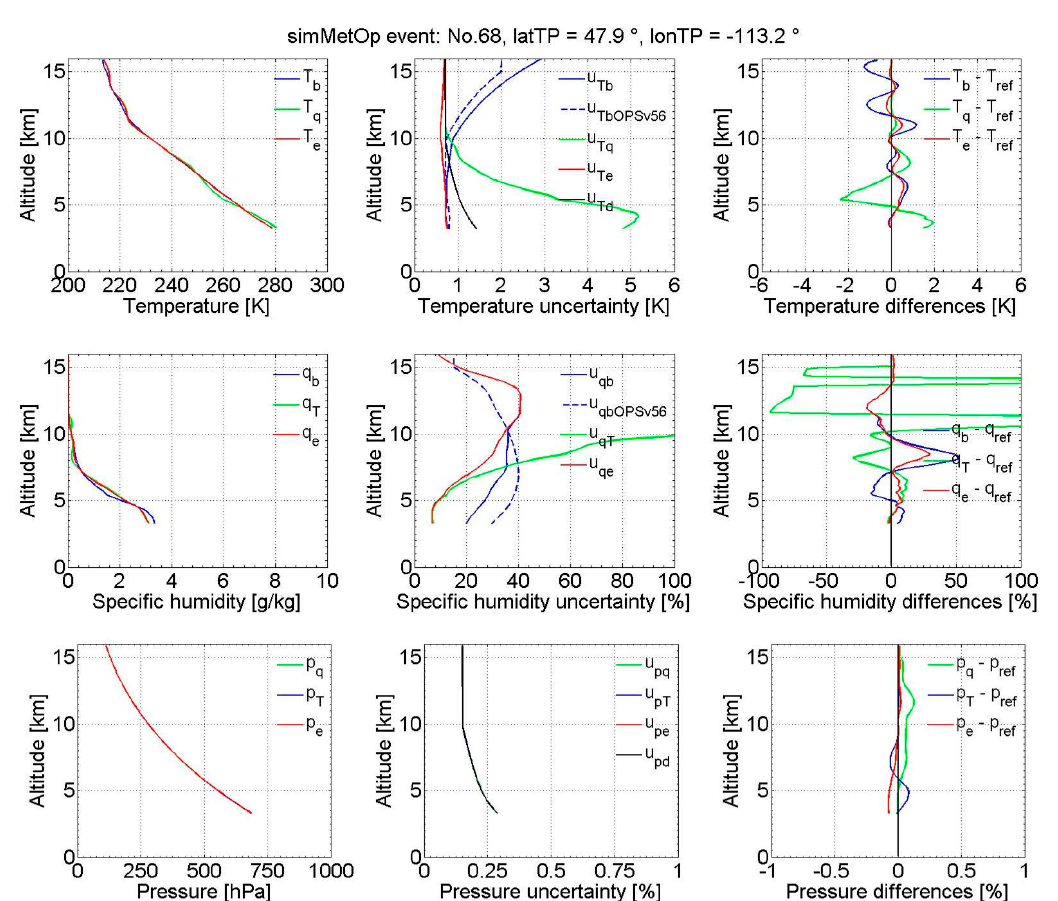
Figure 3. Illustration of input, intermediate, and result variables relevant towards the estimation of optimal temperature (top row), specific humidity (middle row), and pressure (bottom row) of an exemplary simMetOp event (identified on top), for the dynamic approach. In the top row, the left panel shows temperature profiles for background temperature (blue), temperature calculated with specific humidity prescribed (green), and the optimally estimated temperature (red). The middle panel shows the estimated uncertainty profiles for the three profiles shown left and for the observed dry temperature (black) as well as the uncertainty of the background temperature from the OPSv5.6 approach (dashed blue). The right panel shows the differences between the temperature profiles shown left and the reference profiles, where the references profiles are the ECMWF co-located analysis profiles. In the three panels of the middle row, the same type of variables is shown as in the upper row, but for specific humidity q ; thus the intermediate variable here is specific humidity with temperature prescribed (subscript “T”) and there is no dedicated input uncertainty profile in the middle panel (such as u Td in the upper row). Similarly, the bottom row shows the corresponding variables for pressure, whereby here the intermediate pressures from both humidity prescribed (subscript “q”) and temperature prescribed (subscript “T”) are shown together with the optimally estimated pressure (subscript “e”), and the middle panel also illustrates the input uncertainty profile of the dry pressure p d .